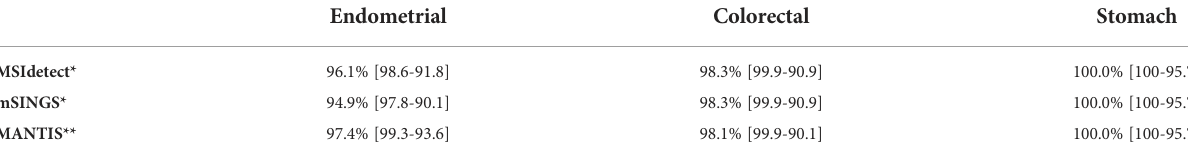
Asterisks indicate that * algorithm relies on comparison of tumor sample with a set of baseline samples or ** matching normal sample. Values inside square brackets indicate the 95% Con fi dence Interval for all